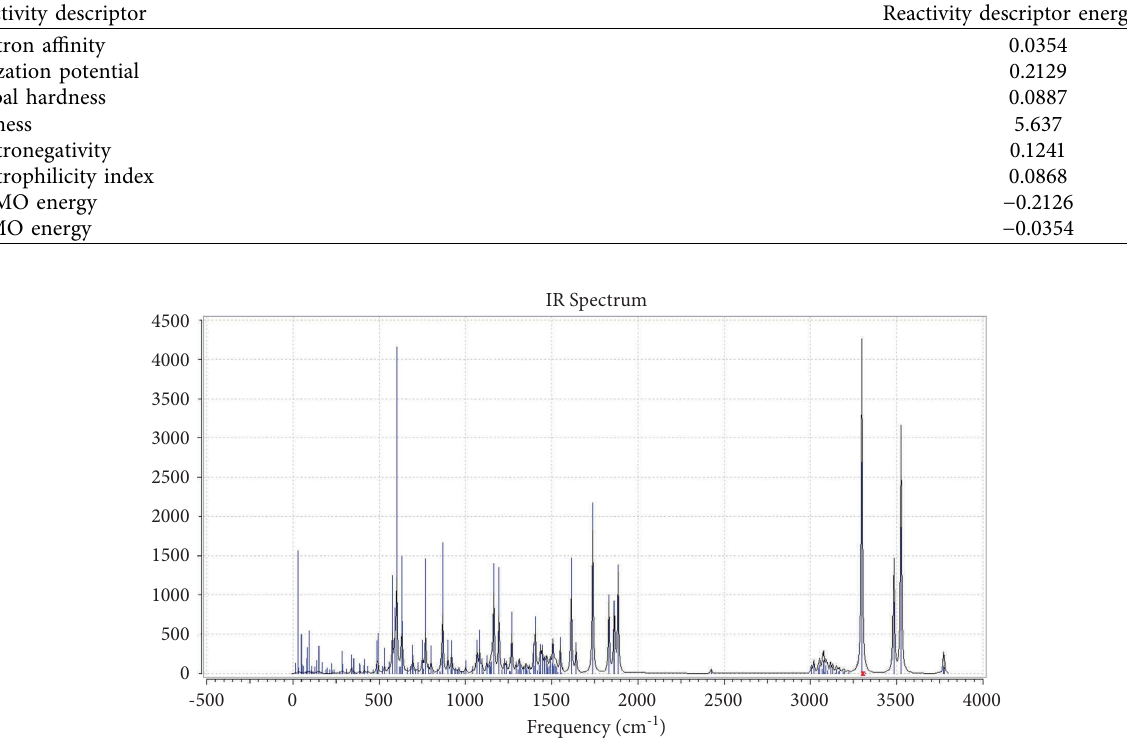
Table 4: Te reactivity descriptors of tofacitinib citrate